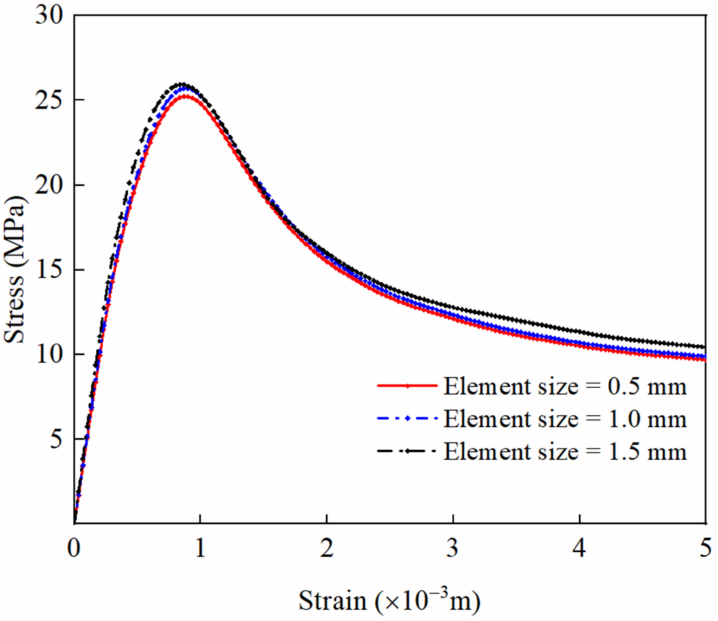
Figure 12. The effect of the mesh size on the stress–strain curve of RAC under uniaxial compression.